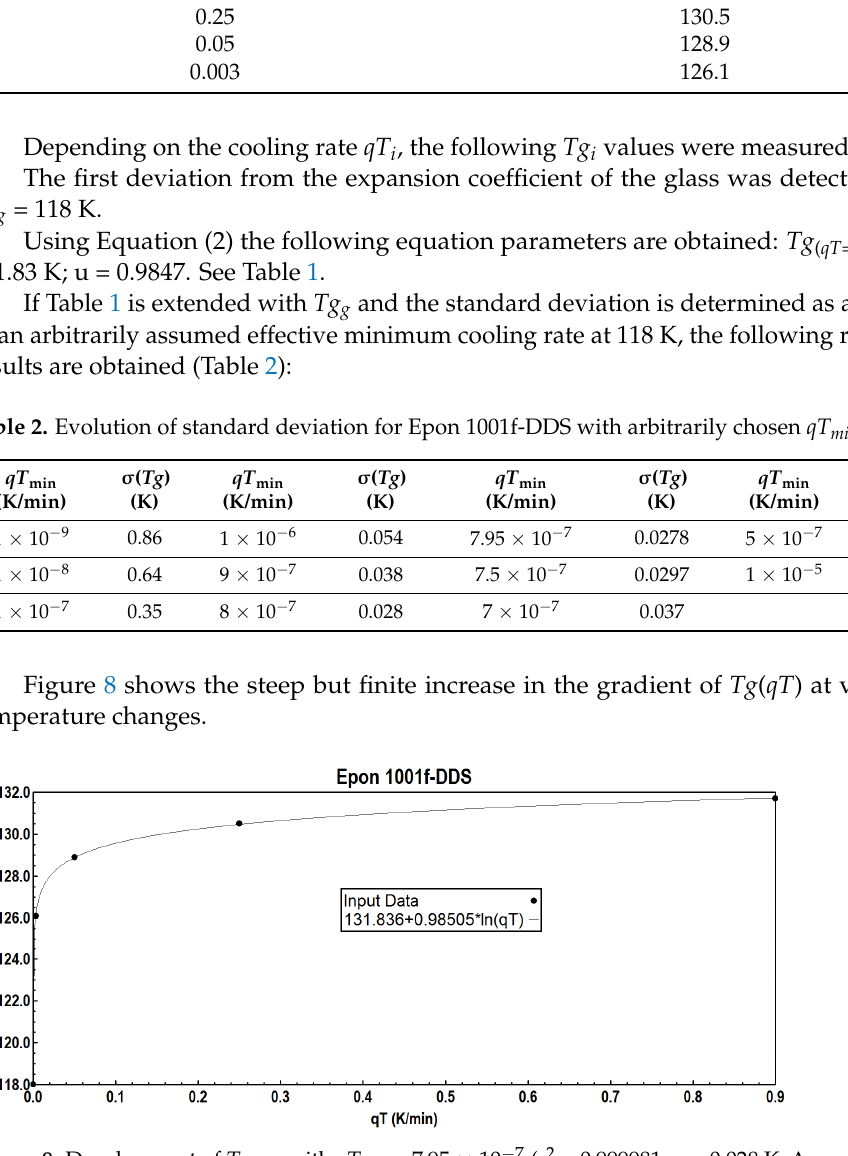
Table 1. Dilatometric results for Epon 1001f-DDS. qT (K/min) Tg i (K) 0.9